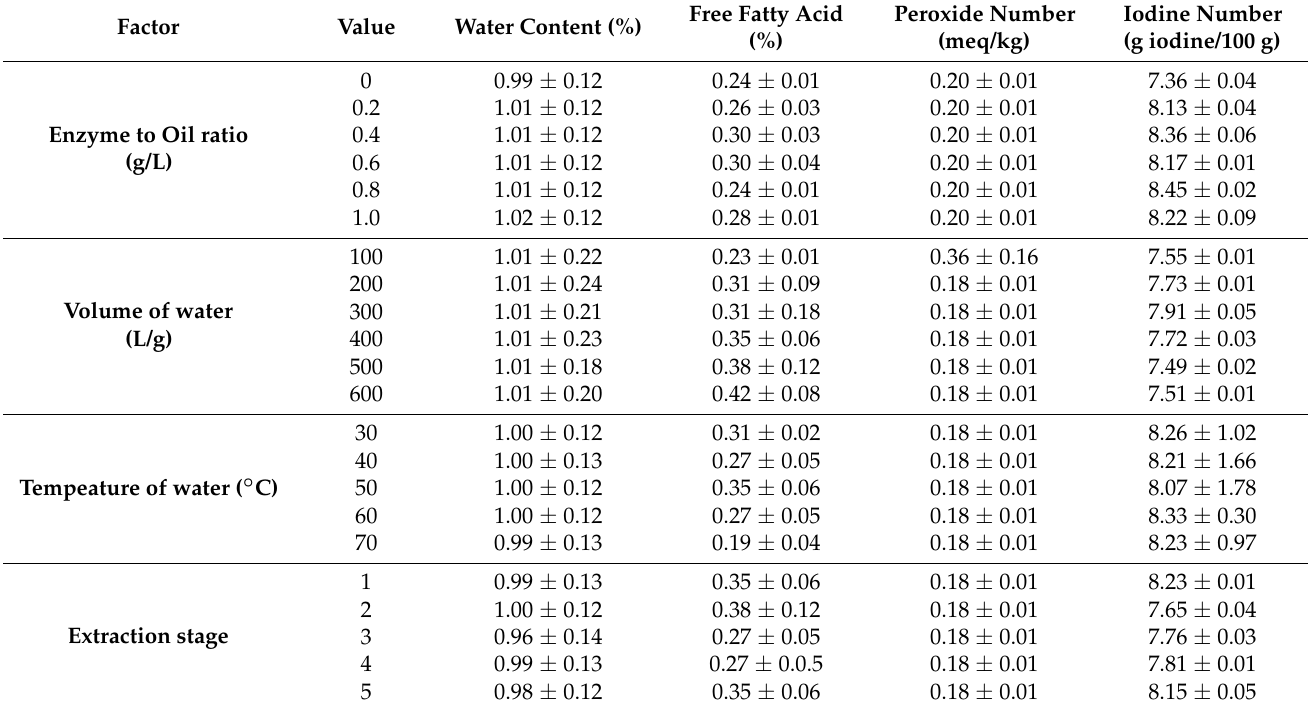
Table 1. Physicochemical properties of virgin coconut oil on variation mass of papain.